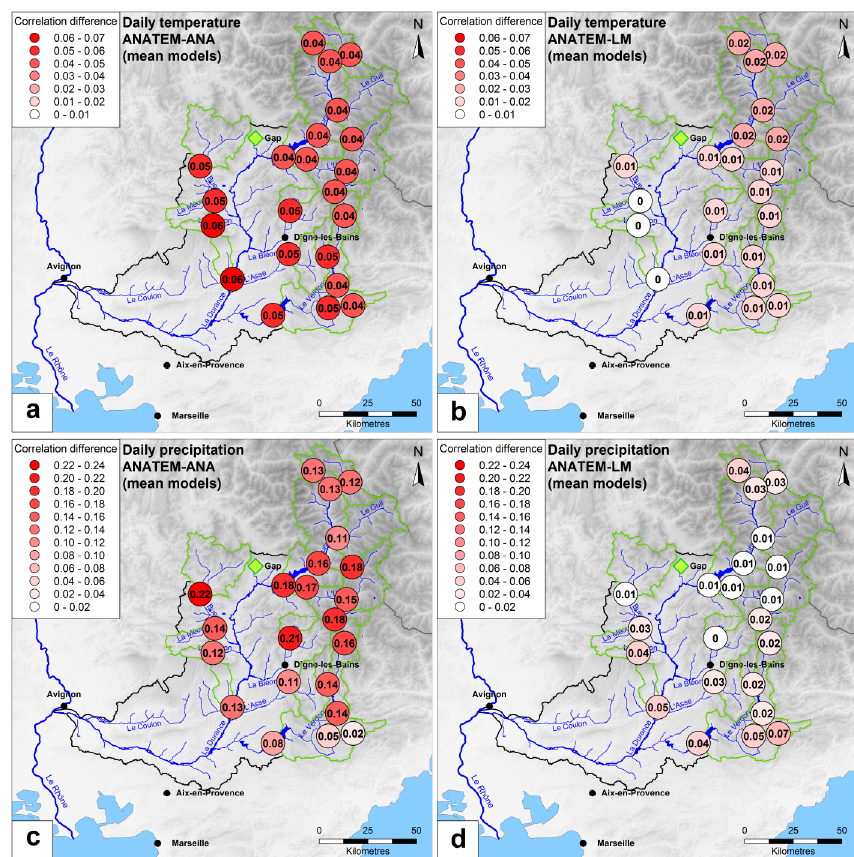
Figure 14. (a, c) Spatial patterns of the contribution of the LM model to ANATEM performance (estimated by the difference between the performance of the ANATEM and ANA models) for air temperature (a) and precipitation (c) reconstructions. (b, d) Spatial patterns of the contribution the ANA model to ANATEM performance (estimated by the difference between the performance of the ANATEM and LM models) for air temperature (b) and precipitation (d) reconstructions. Note the different colour scales for precipitation and temperature reconstructions (daily time